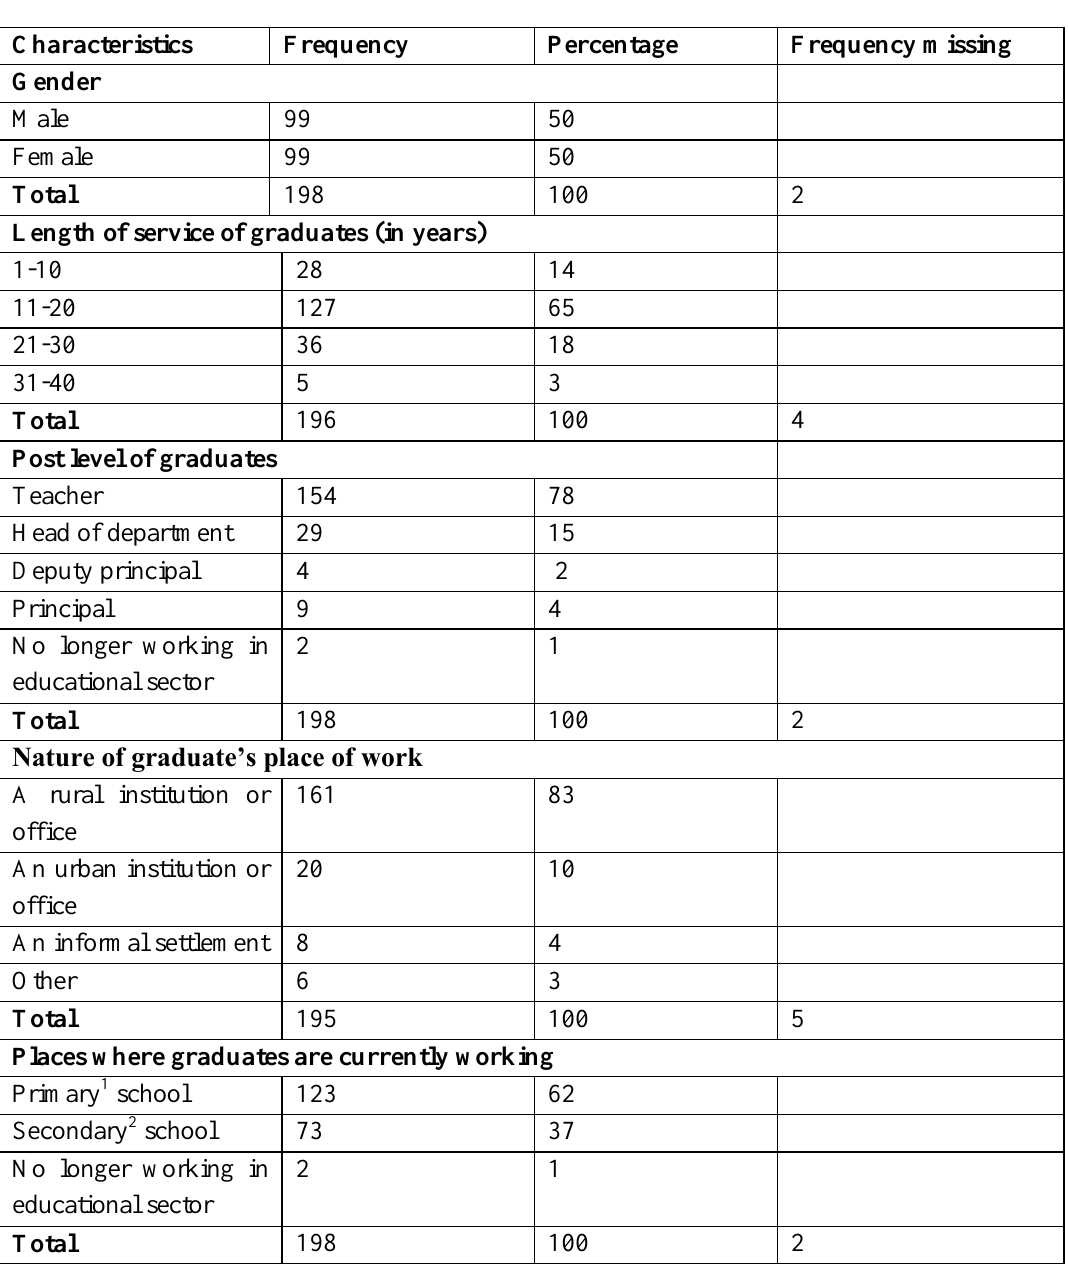
Table 3 Graduates’ Background Information (N = 200)